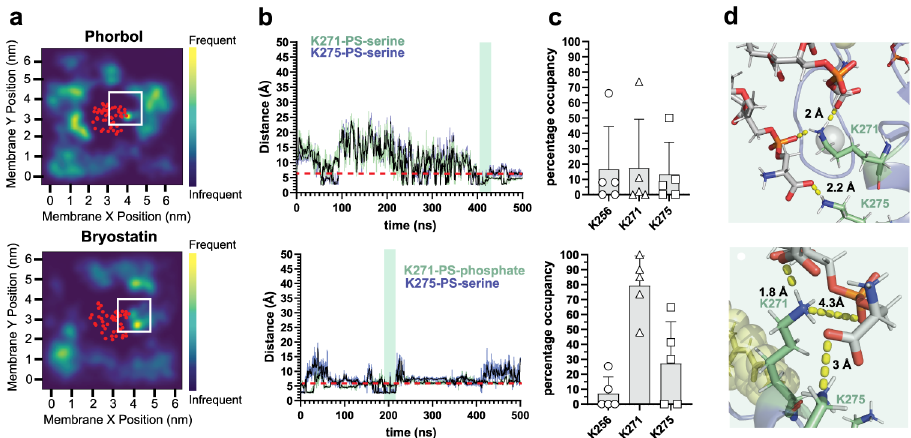
Figure 1. Interactions between PS and lysine side chains of δ C1b. Top panels show δ C1b-phorbol simulations. Bottom panels show δ C1b-bryostatin simulations. ( a ) Heatmaps show the localization of PS lipids in the inner leaflet over a 500 ns simulation period and are representative of five simulations (see Figure S2 for full dataset). The red dots indicate the average position of the backbone C α of δ C1b. ( b ) Interaction lifetimes of PS-lysine interactions. The dotted line indicates the 6 Å cutoff used to determine occupancy in ( c ). The shaded area indicates the time frame in which the structures shown in ( d ) are obtained. ( c ) Total occupancy time of different lysine residues with PS over all five simulations. Bars indicate the mean, error bars represent the standard error of the mean and each point represents a single independent simulation. ( d ) Representative structural interactions from the shaded area in ( b ). PS lipid is colored grey sticks while δ C1b-lysine residues are colored pale green sticks. Charge–charge interactions are indicated by the dashed yellow line and the interaction distance is indicated above the residue to which PS is interacting.